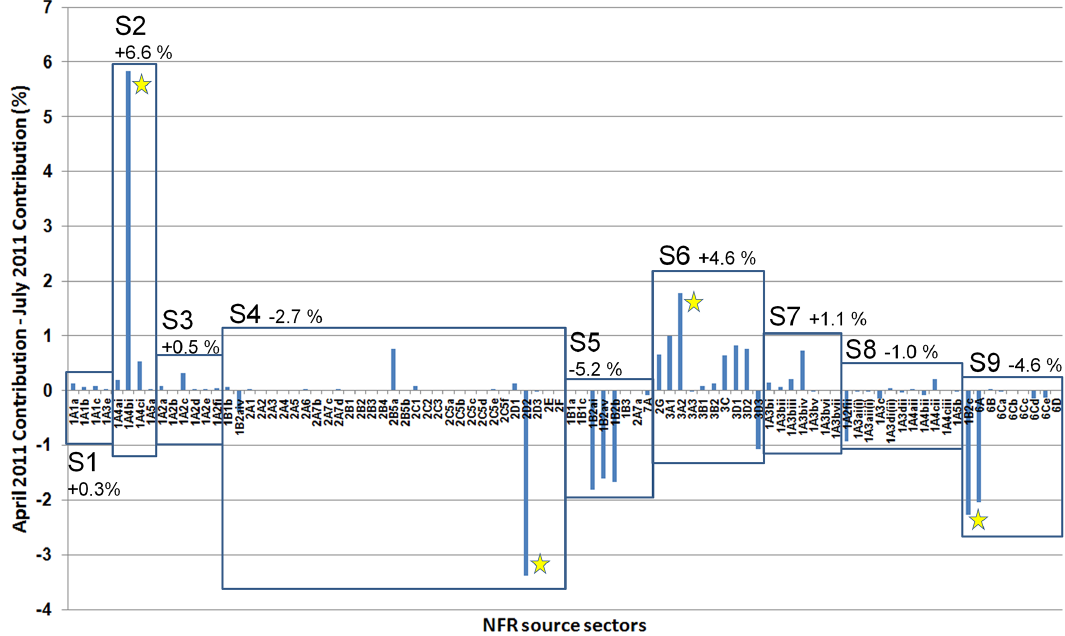
Figure 14. Difference between NFR source sector contributions to average VOC back-trajectory emission estimates (VOC TEE) in April and July 2011 at Harwell. Also shown are the change in contribution of the SNAP source sectors. These were calculated from the VOC TEE prior to disaggregation and do not represent the sum of the contribution changes of the constituent NFR source sectors. The source sectors identified by stars have the largest changes between April and July (Sect.